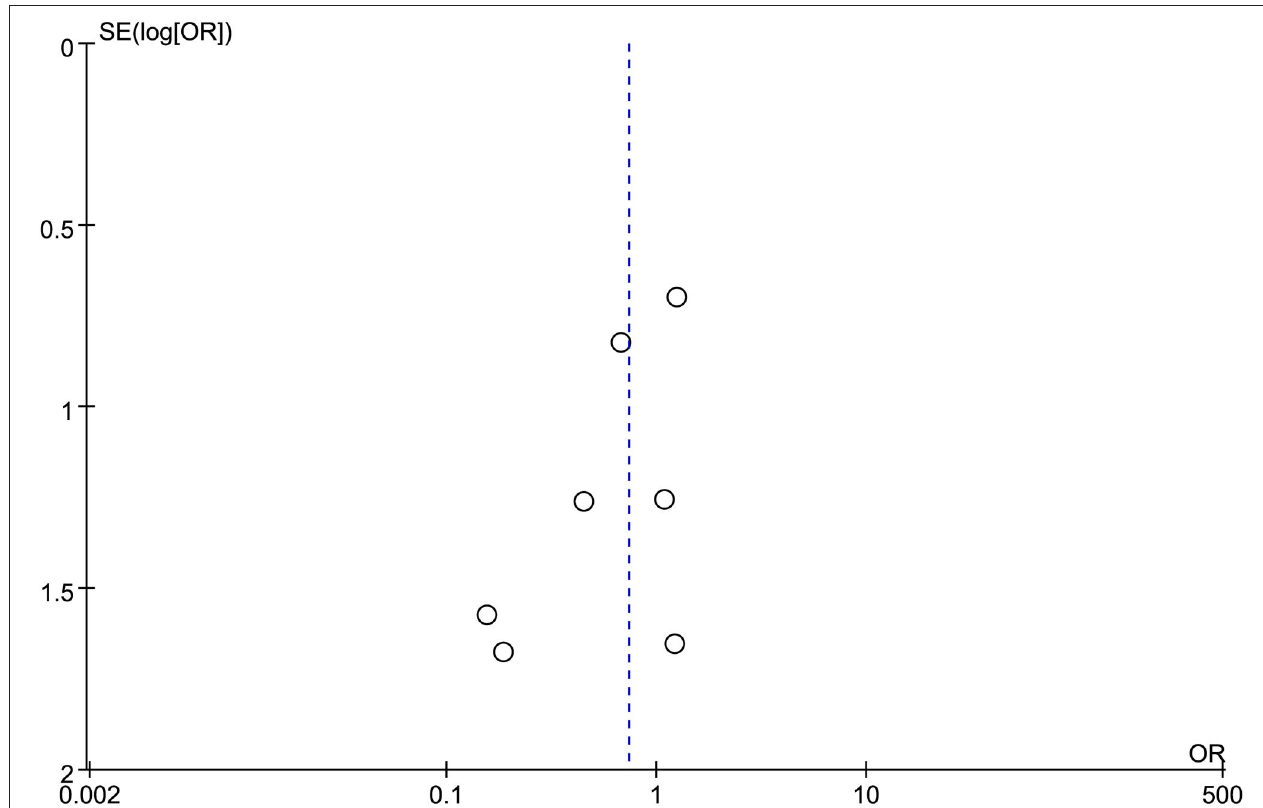
FIGURE 4 | Funnel plot of technical success between EUS-CDS and EUS-HGS.